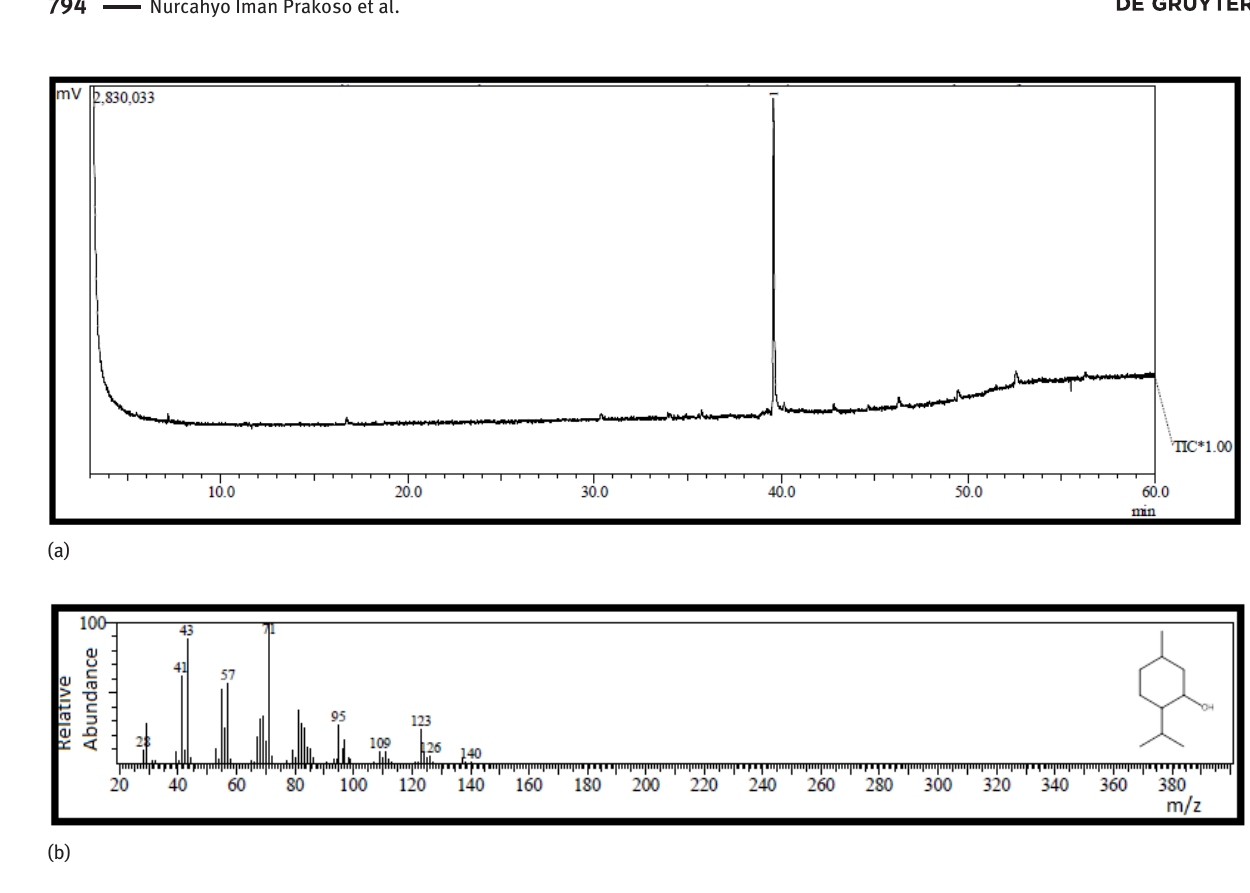
Figure 6: Chromatogram (a) and mass spectra (b) from second major compound,